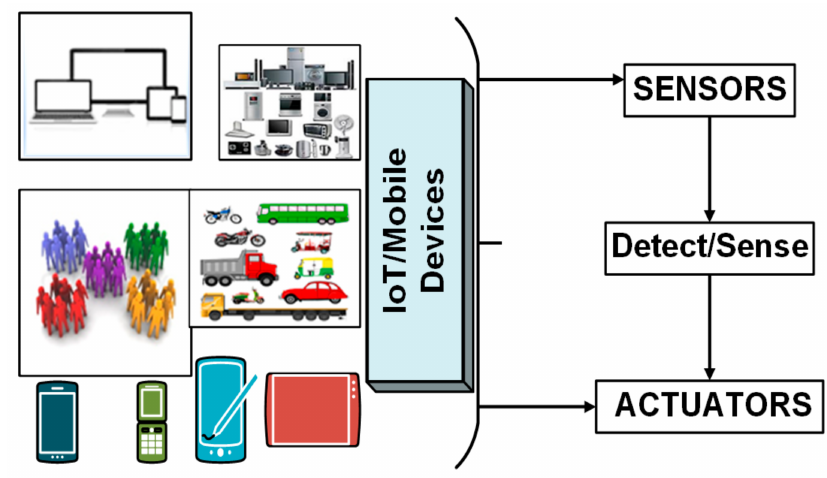
Figure 2. Mobile cloud with IoT and mobile devices for data sensing.